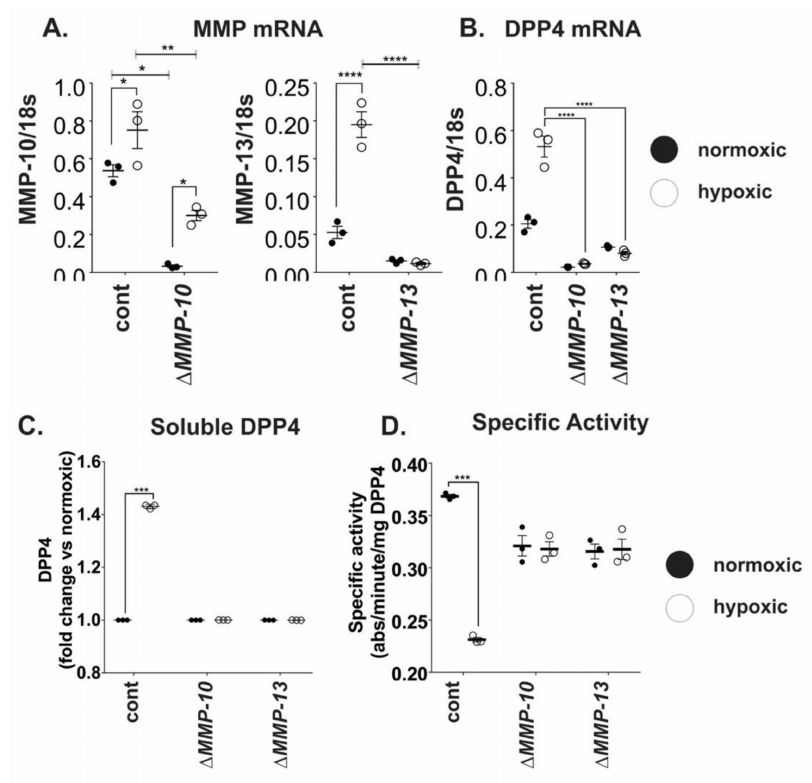
Figure 5. MMP10 and MMP13 a ff ect DPP4 expression and release from ovarian cancer cells. OVCAR4 cells with stable shRNA knockdown of MMP10 or MMP13 were cultured under normoxia or hypoxia for 48 h. Total RNA was extracted, and qRT-PCR performed to confirm ( A ) knockdown of MMP10 and MMP13 relative to controls, and ( B ) examine the e ff ects of MMP10 and MMP13 on DPP4 mRNA expression. DPP4 ELISA and enzyme assay were performed on conditioned media of cells to assess changes in ( C ) sDPP4 release and ( D ) specific activity induced by the downregulation of MMP10 and MMP13 . The data represent the mean ± SD, n = 3 / group. * p < 0.05; ** p < 0.01; *** p < 0.001; **** p <